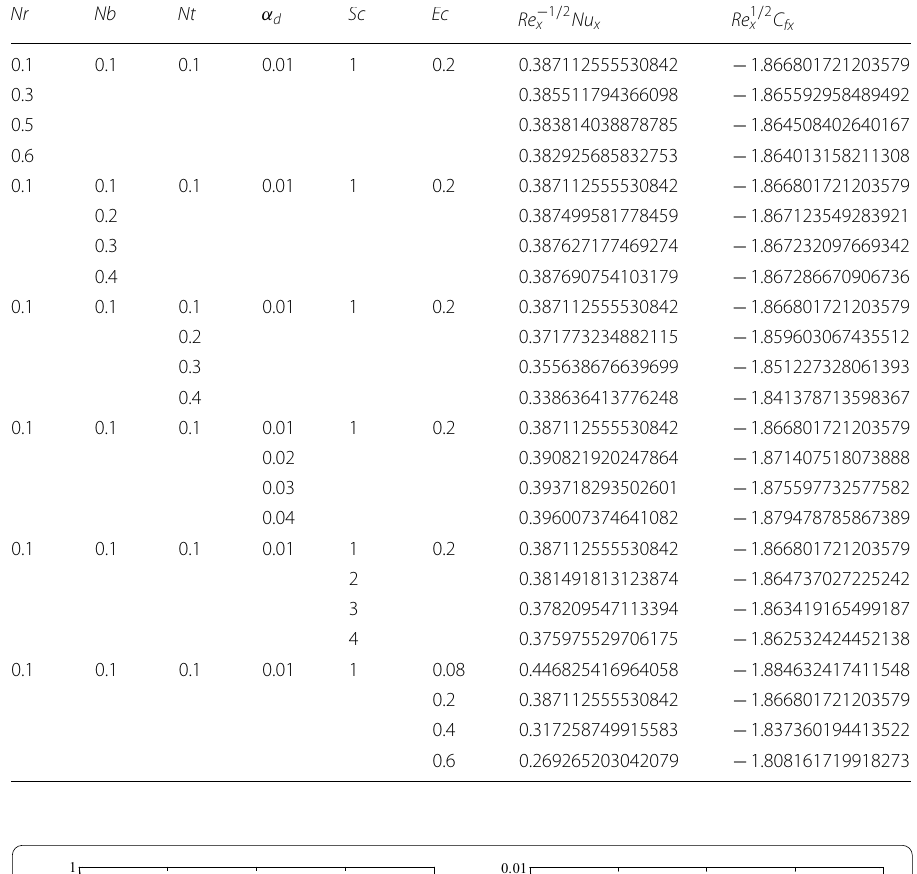
Table 3 Values of Nusselt number Re − 1 / 2 x Nu x and skin friction Re 1 / 2 x C fx for several values of Nr , Nb , Nt , 0.1 α d , Sc , and Ec for Ŵ =